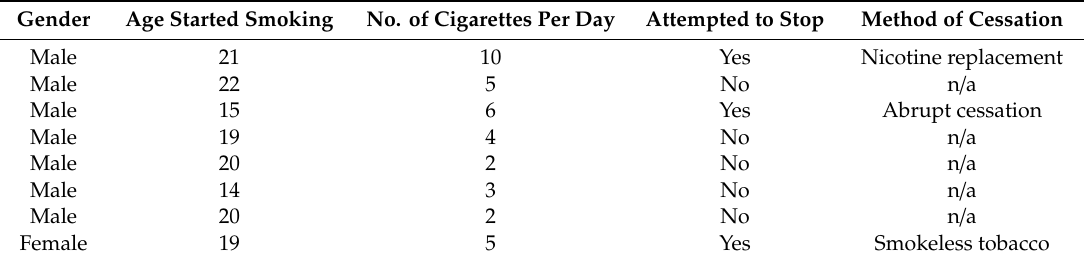
Table 4. Demographics and attempted smoking cessation of students who smoke ( n = 8).